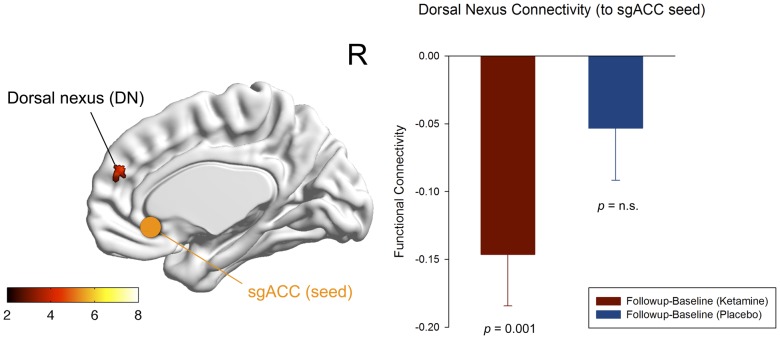
Functional connectivity of the affective network (AN).Significant voxels of the dorsal nexus (DMPFC) showing reduced functional connectivity to the subgenual anterior cingulate cortex (sgACC) seed region (blue) 24 hours after ketamine administration (n = 17, whole brain paired t-test: baseline(ketamine)-follow-up(ketamine); puncorr<0.001, extent threshold of k>13, corresponds to a cluster-level pcorr<0.1 indicating trend-level significance). The color bar indicates z values. The bar diagram represents the change in functional connectivity (Fisher z-transformed correlation values) of the dorsal nexus to the sgACC from baseline to follow-up for the ketamine (red) and placebo condition (blue) (n = 17, paired t-test: p = 0.001; error bars = s.e.m.).